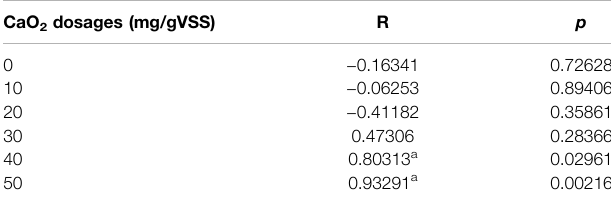
TABLE 2 | Pearson correlation coef fi cients between CST and DD SCOD at different CaO 2